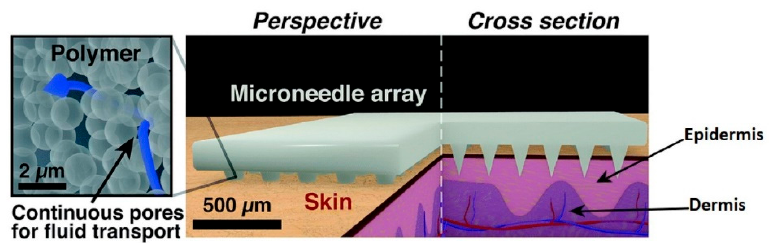
Figure 4. Schematic diagram of microneedles inserted into the skin for interstitial fluid extraction [69].